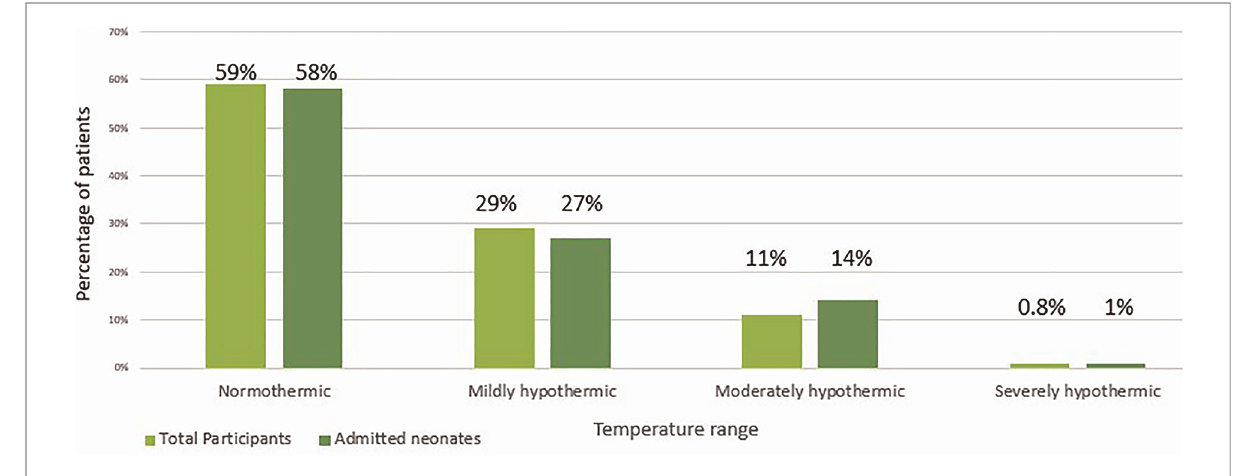
FIGURE 2 Comparison of severity of hypothermia amongst total and admitted neonates.